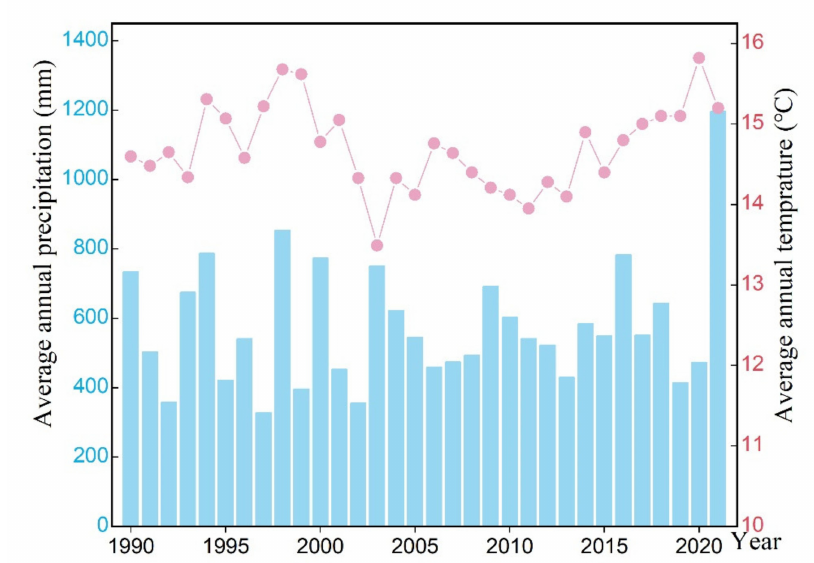
Figure 2. Average annual precipitation and average annual temperature in the study area from 1990 to 2021. The figure was plotted by Origin2022